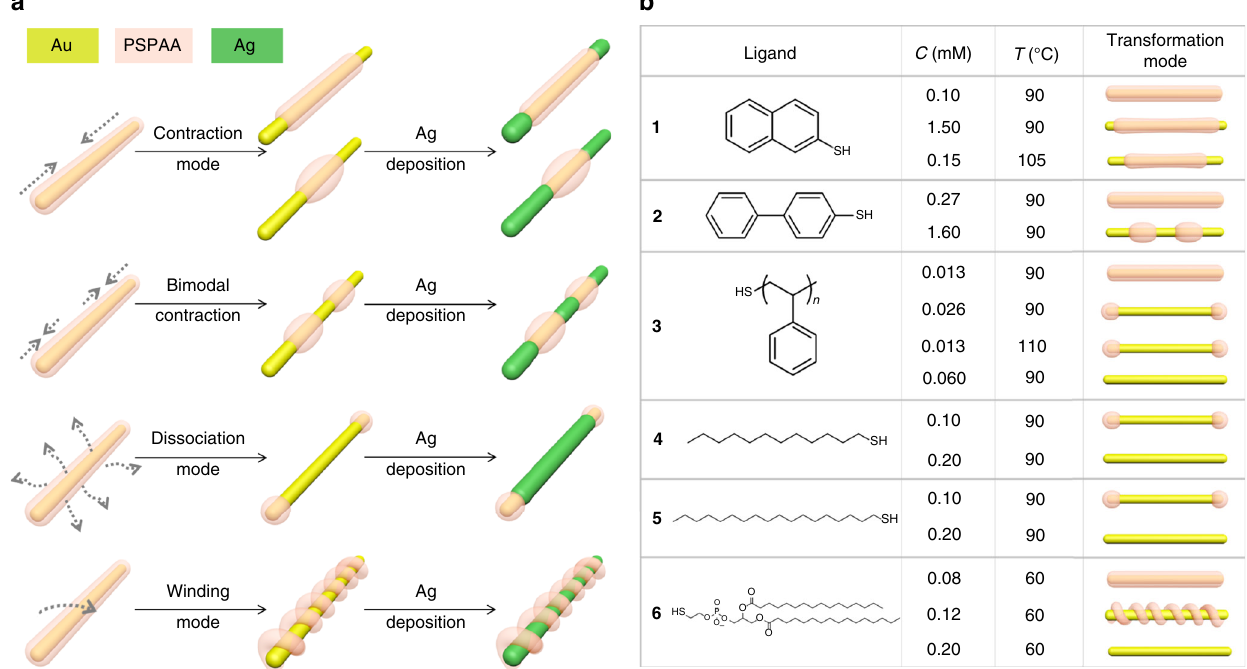
Fig. 1 Schematics illustrating the four transformation modes of (AuNR-ligand)@PSPAA. a Contraction, bimodal contraction, dissociation, and winding modes (left panel). b The ligand dependence is summarized in the Table on the right panel. Ligands 1 – 6 are 2-naphthalenethiol, biphenyl-4-thiol, thiol- terminated polystyrene, 1-dodecanethiol, 1-octadecanethiol, and a thiol-ended phospholipid, 2-dipalmitoyl- sn -glycero-3-phosphothioethanol (sodium salt), respectively. C (mM) the concentration of the ligand in the initial encapsulation step, T the temperature used for transforming the